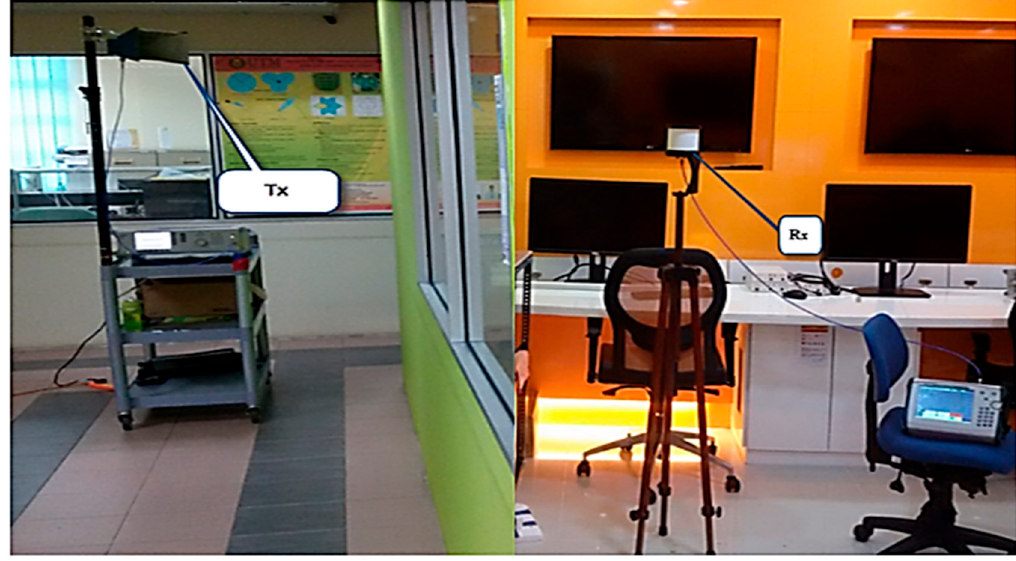
Figure 1. Measurement setup.